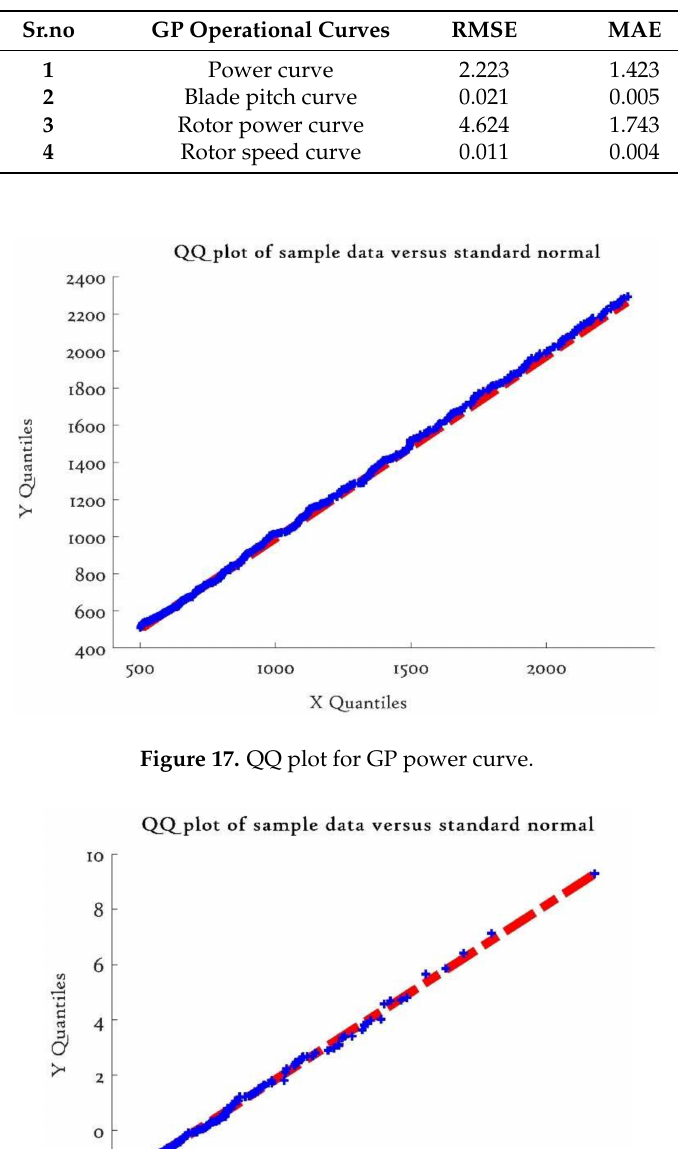
Table 2. Statistical error for different GP models from QQ plots.